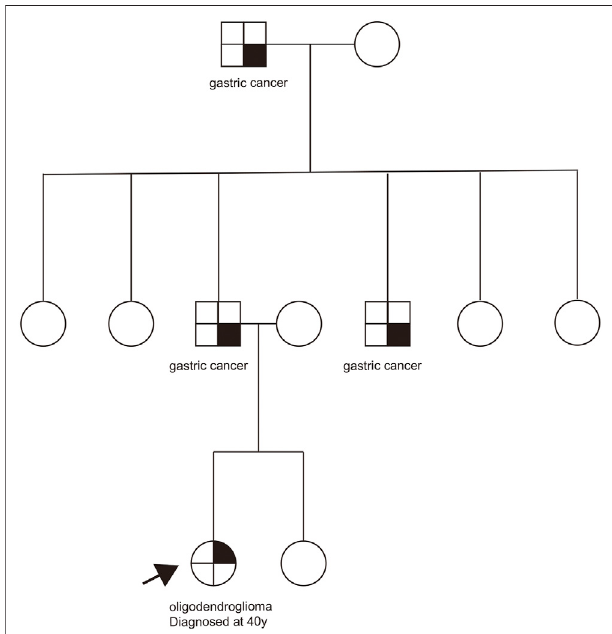
FIGURE 2 | Pedigree chart of this family with cancer